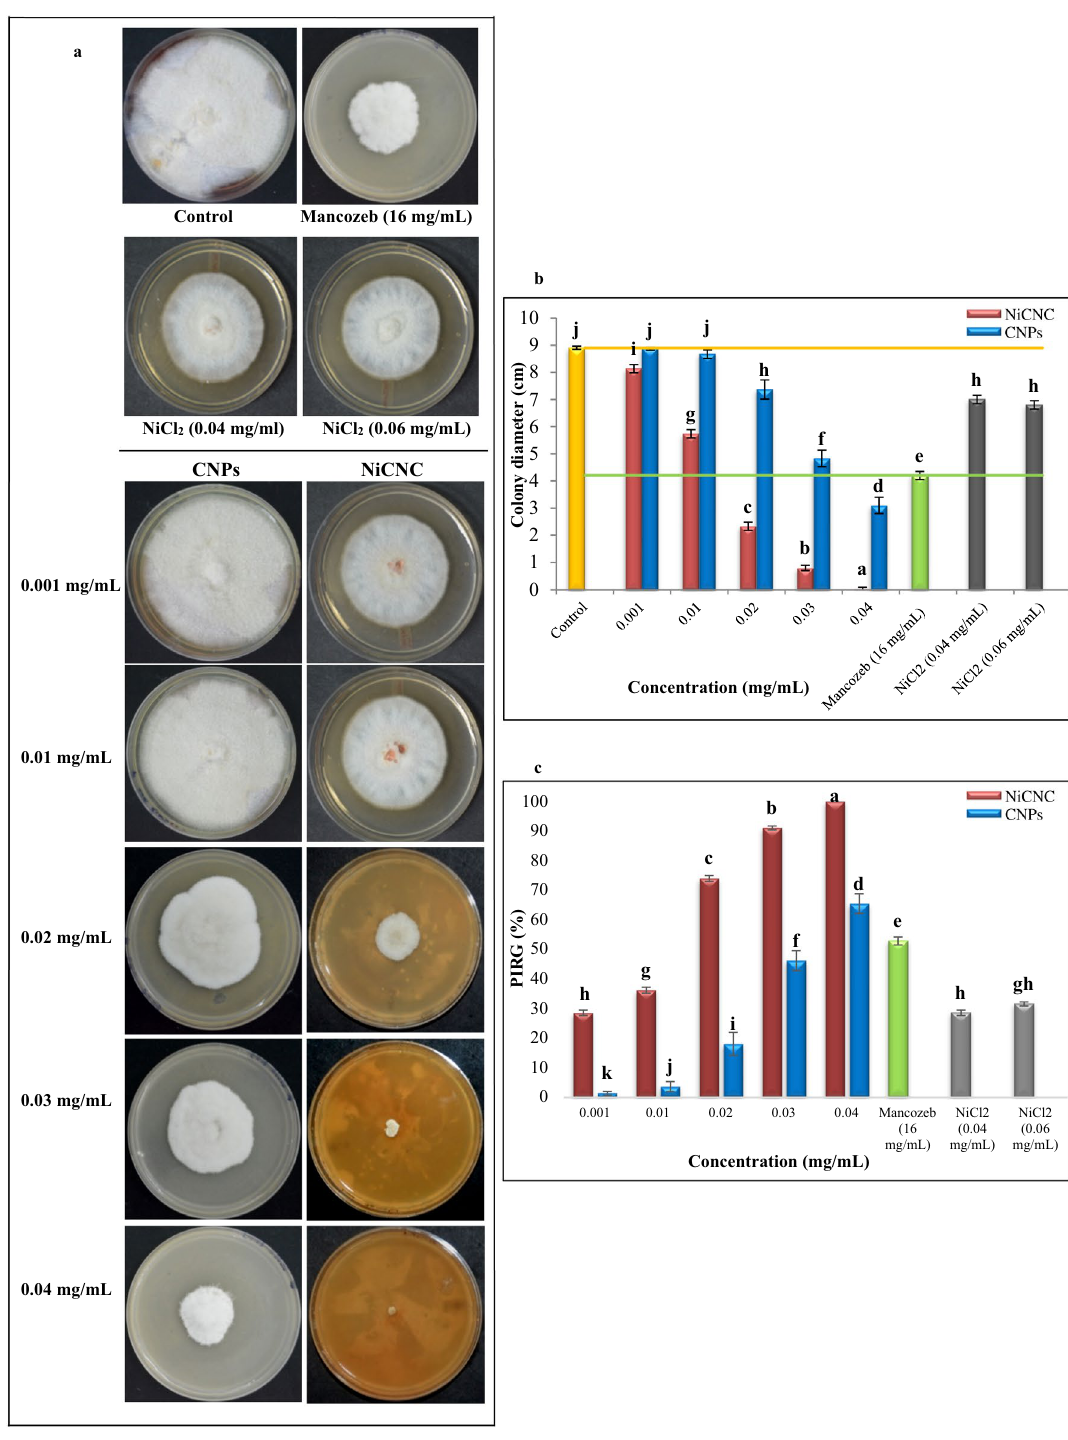
Figure 2. Effect of CNPs and NiCNC on mycelium radial growth of F. solani . ( a ) Mycelium radial growth of F. solani with different concentrations (0.001, 0.01, 0.02, 0.03 and 0.04 mg/mL) of CNPs and NiCNC on PDA plate; ( b ) Graphical representation of colony diameter of F. solani with different concentrations of CNPs and NiCNC in comparison with Mancozeb, NiCl 2 and control at 7 days post-incubation; ( c ) Graph showing Percent Inhibition of Radial Growth (PIRG) of F. solani under tested concentrations of CNPs and NiCNC. Values are averages of three replicates (n = 3), error bars indicate standard deviation (SD) and different letters (a, b, c, etc.) indicate significant difference between treatments at p ≤ 0.05 by Duncan’s Multiple Range